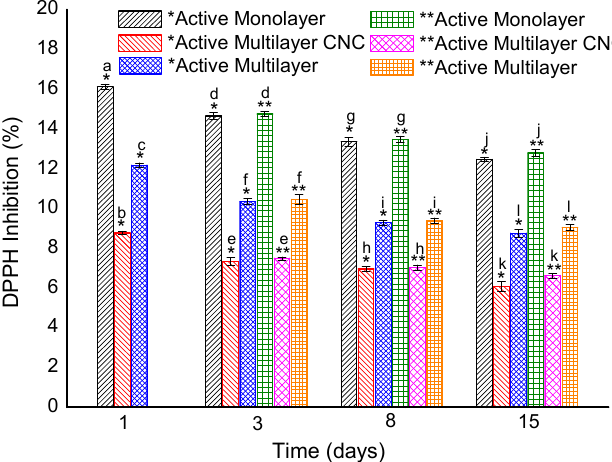
Figure 4. Inhibition percentage (%) of 2,2-diphenyl-1-picrylhydrazyl radical (DPPH) of the active multilayer films with and without cellulose nanocrystal (CNC) coatings for 15 days. * Open system. ** Closed system. a–l: Different superscripts within the same column indicate significant differences among samples ( p < 0.05). Table 6. Concentration (µ g eq. Trolox/g sample) of 2,2-diphenyl-1-picrylhydrazyl radical (DPPH) of the active multilayer films with and without cellulose nanocrystal (CNC) coatings in the open a closed system for 15 days.